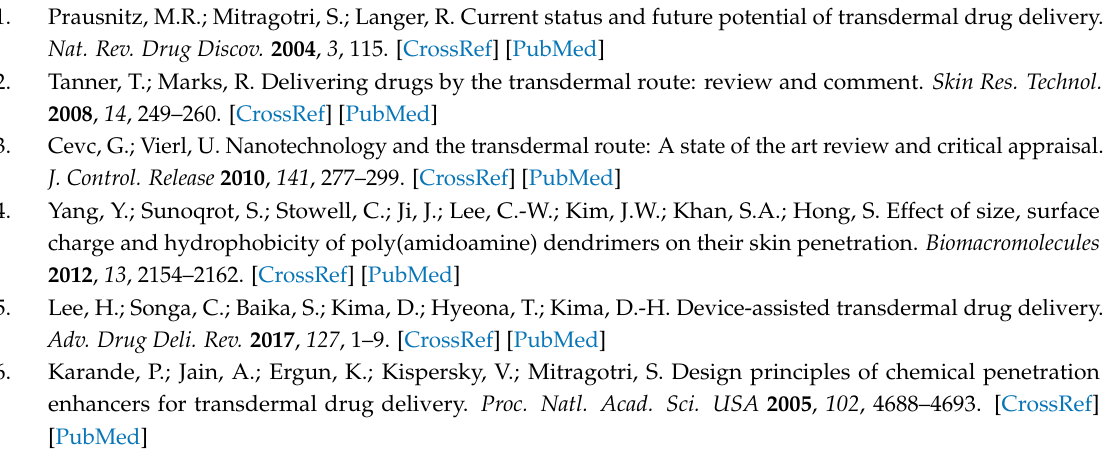
intermolecular interaction between VBAC and ibuprofen. Figure S5: The correlation of cross-linker ratio between 5 and 10 mol % against to elastic moduli (G’) and steady flux permeation of PS gel (Gel A–D) with 4 and 8 M limonene concentration and Table S1: Storage modulus and permeation parameter of PS